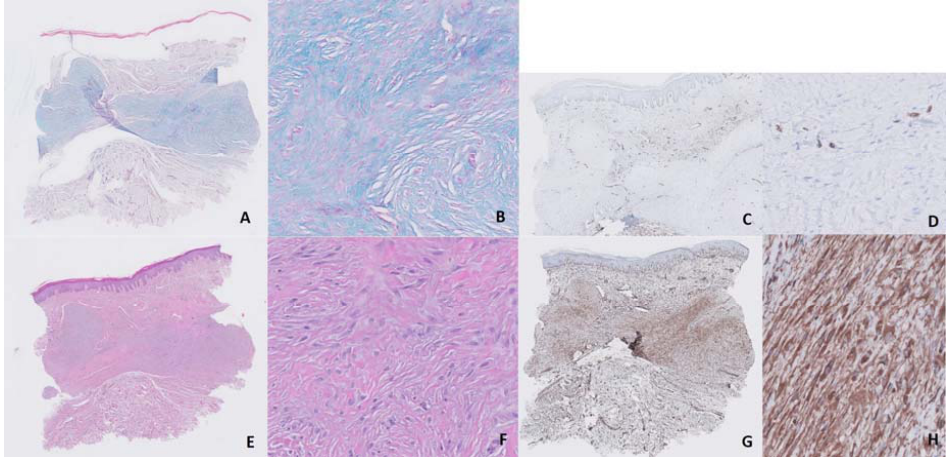
Figure 2. Before treatment, we observed basal deposits of mucin ( A , B , 10 × and 40 × , respectively, alcian blue staining), few vascular structures ( C , D , 10 × and 40 × , respectively, CD34 staining), disorganized collagen ( E , F , 10 × and 40 × , respectively, hematoxylin–eosin staining) and a rich cellularity ( G , H , 10 × and 40 × , respectively, vimentin staining).